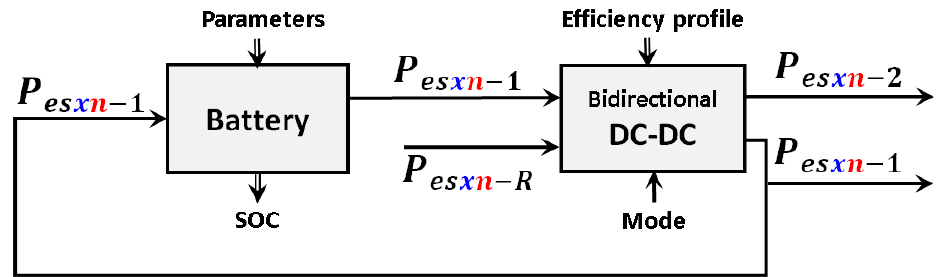
Figure 4. Block diagram of the programmed model of ESU.